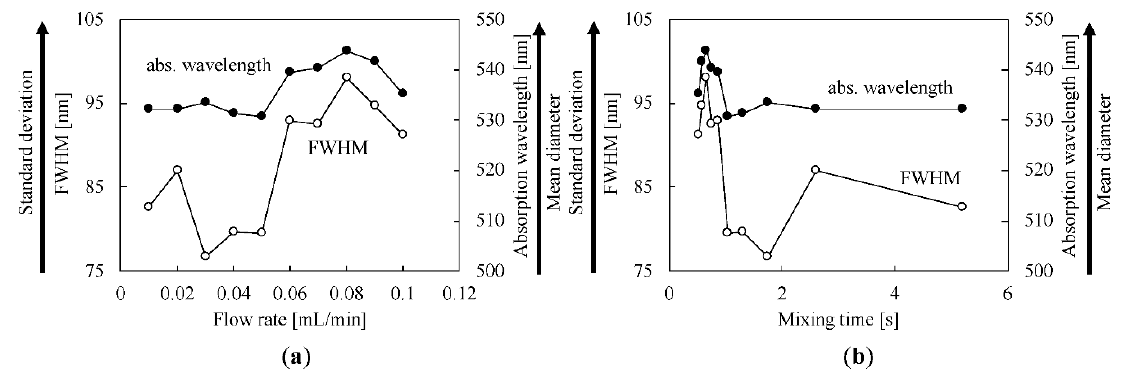
Figure 3. ( a ) The full width at half maximum (FWHM) and absorption wavelength at the peak as a function of the flow rate. ( b ) FWHM and absorption wavelength at the peak as a function of mixing